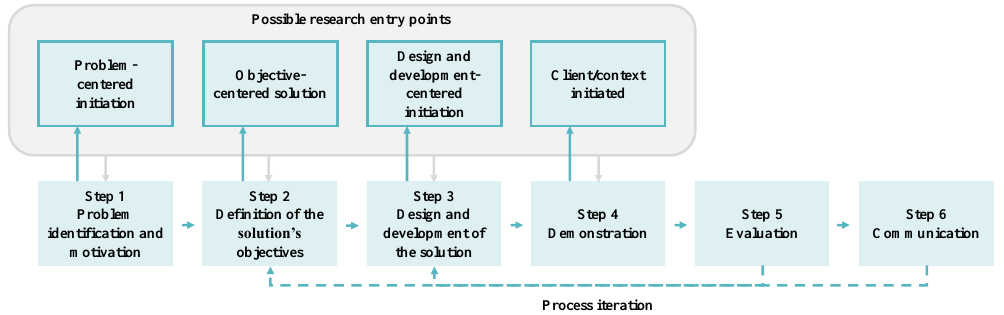
Figure 2. Schematic representation of the steps encompassed in the DSR methodology (adapted from